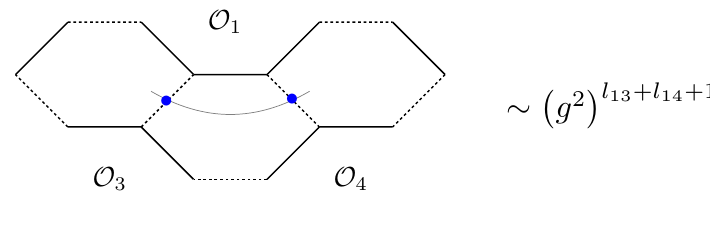
Figure 5 . Two-particle